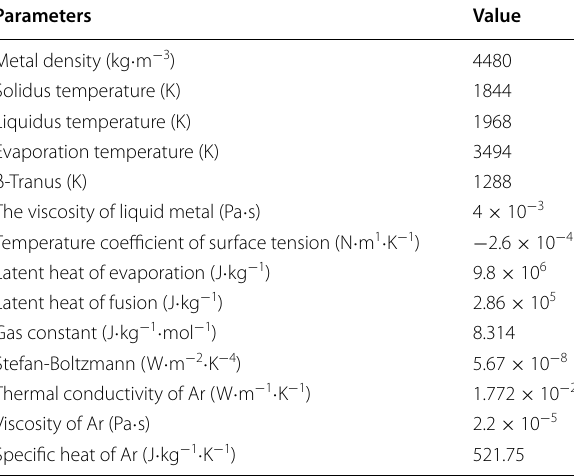
Table 2 Thermophysical properties of the alloy and Ar